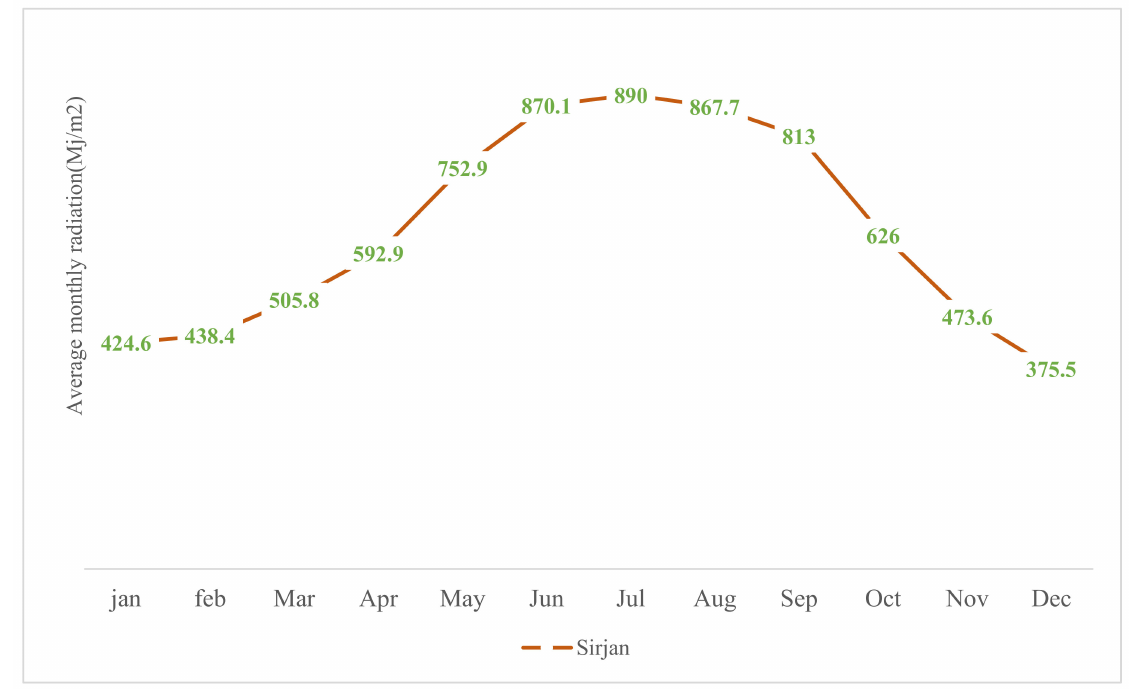
Figure 13. Average monthly radiation (MJ/m 2 ) in Sirjan city [3].